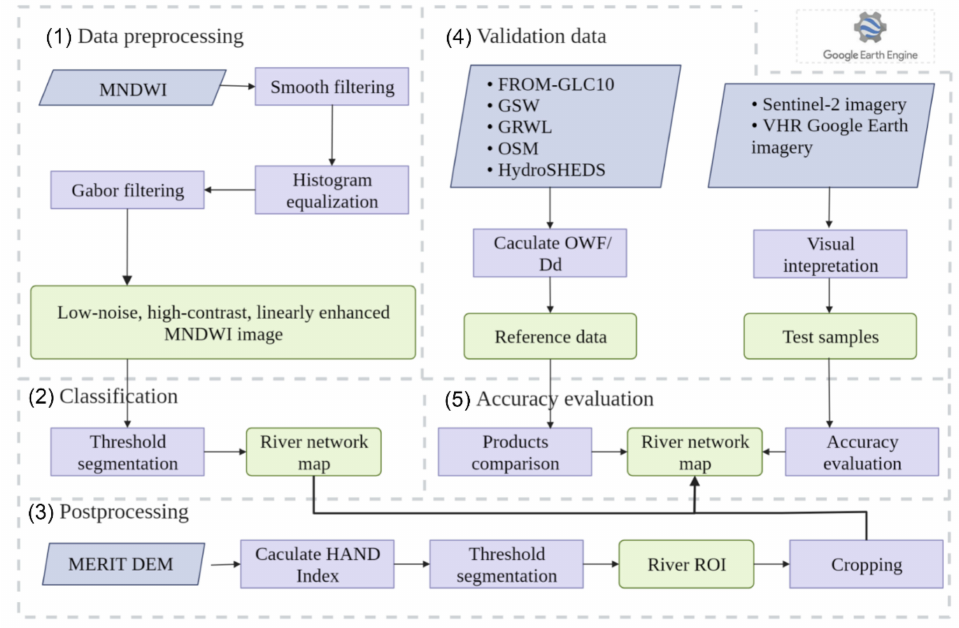
Figure 3. Workflow of remote sensing river